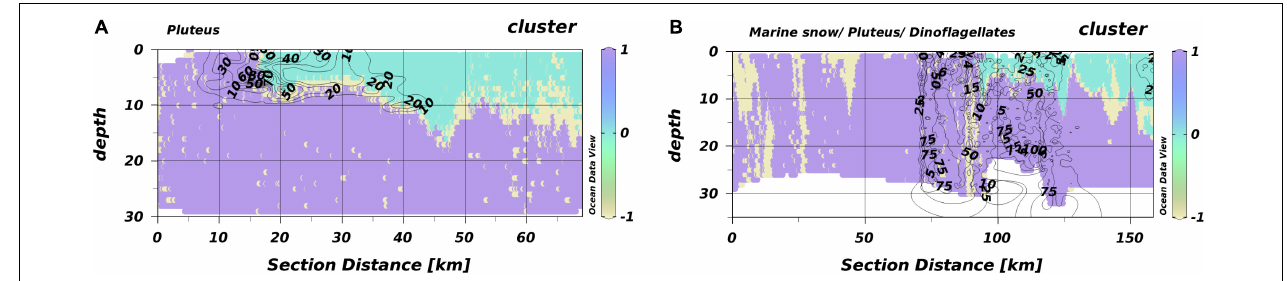
FIGURE 8 | Habitat maps for T1 and T2 from HE534. The isolines give the densities (N l − 1 ) of pluteus for T1. Isolines in the figure of T2 include pluteus, marine snow, and dinoflagellates (all in N l − 1 ). (A) T1 and (B) T2. Different colors represent different macro-habitats. Different numbers are the respective densities indicated by the